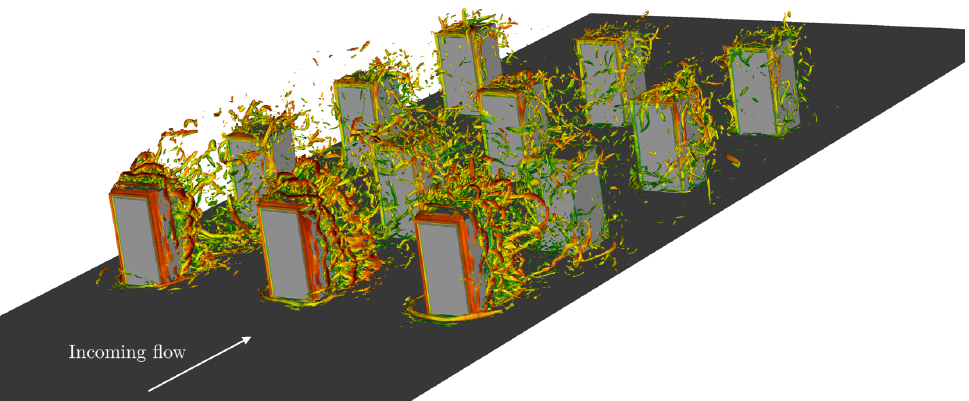
Figure 1. Instantaneous visualization of the flow under study showing vortical structures identified with the λ 2 method [40]. The shown isosurface is − 50 (scaled with the freestream velocity and the obstacle height) and the structures are colored in terms of the streamwise velocity from (dark blue) − 1 to (dark red)